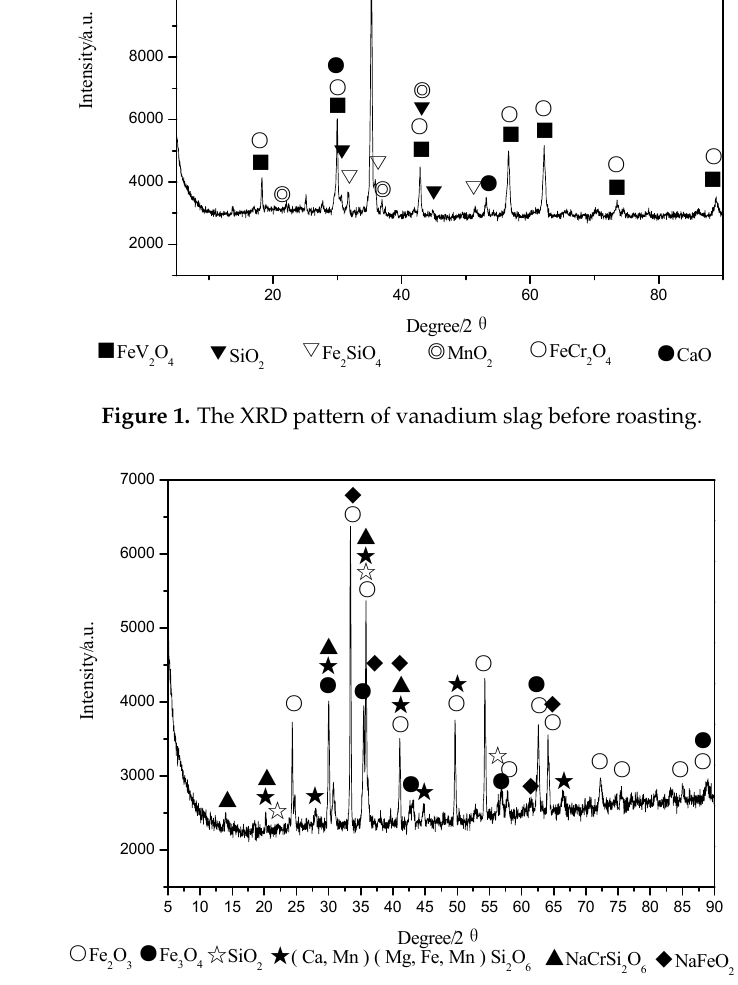
Figure 2. The XRD pattern of vanadium slag after roasting.